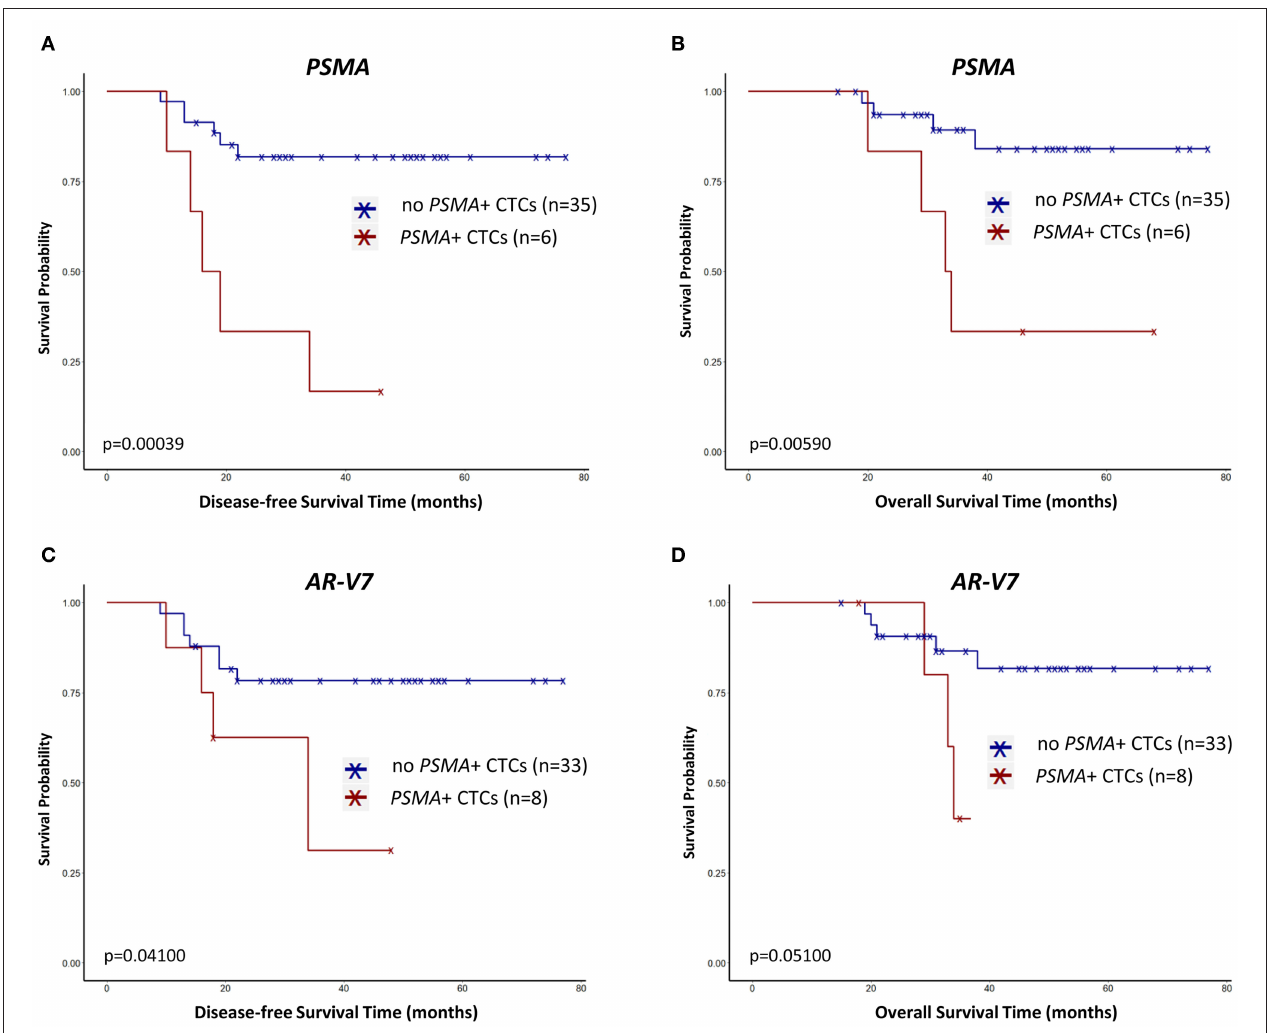
FIGURE 2 | Survival curves regarding PSMA + CTCs (A,B) and AR-V7 + CTCs (C,B) in primary TNBC patients before neoadjuvant treatment. Survival intervals were screened from the time of first diagnosis until the date of recurrence [here disease-free survival; ( A,C )] or death [overall survival; ( B,D )] and calculated with Kaplan-Meier estimator (Log-rank